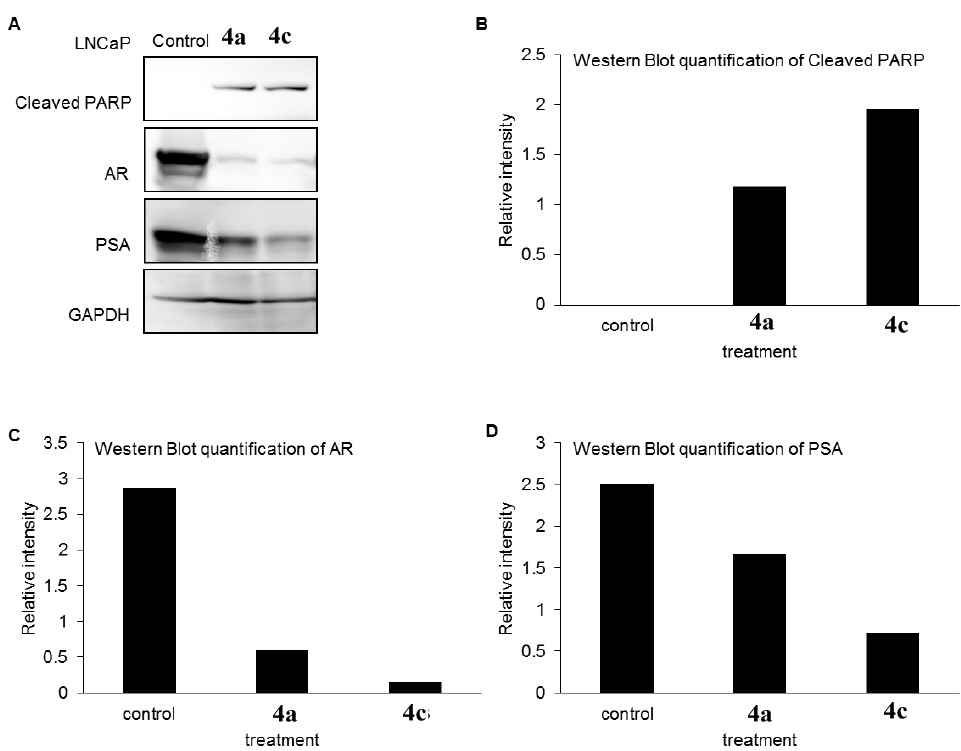
Figure 5. Nickel complexes induce LNCaP cell death ( A ) through inhibition of cleaved PARP ( B ), AR ( C ), and PSA ( D ) signaling.